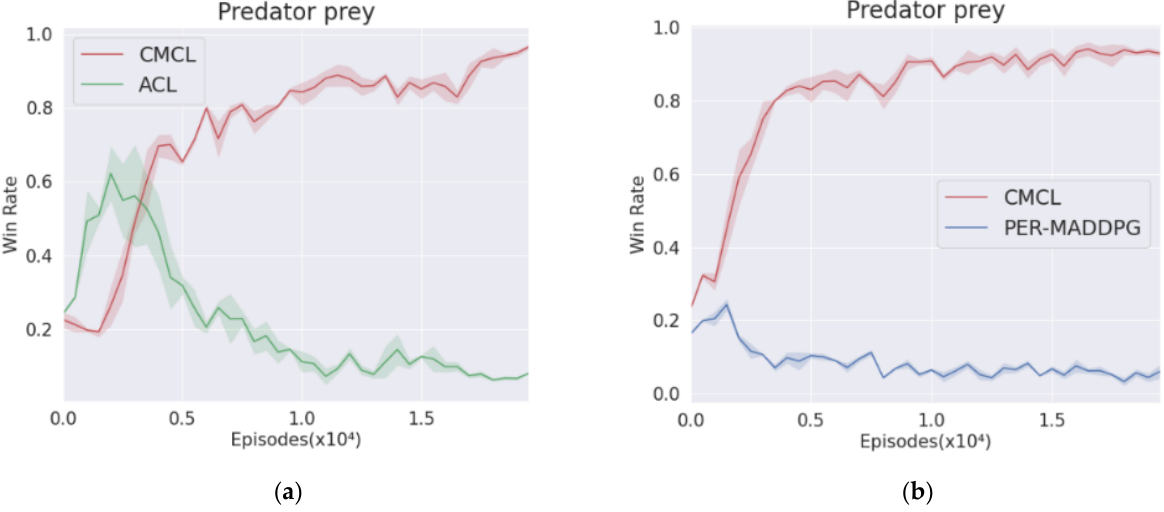
Figure 13. The win rate of predator and prey using two algorithms respectively in the adversarial environment. ( a ) CMCL vs. ACL; ( b ) CMCL vs. PER-MADDPG.